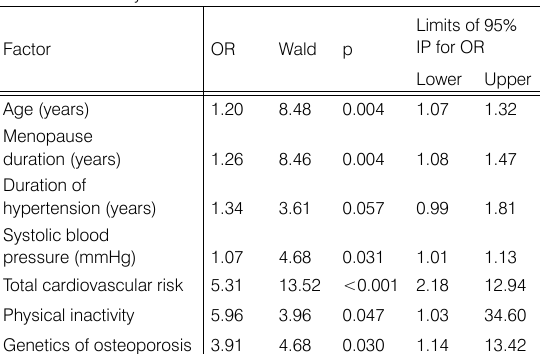
Table 3. Values of OR for estimation of relationship between decreased bone density (osteopenia and osteoporosis) and risk factors; results of multivariate logistic regression